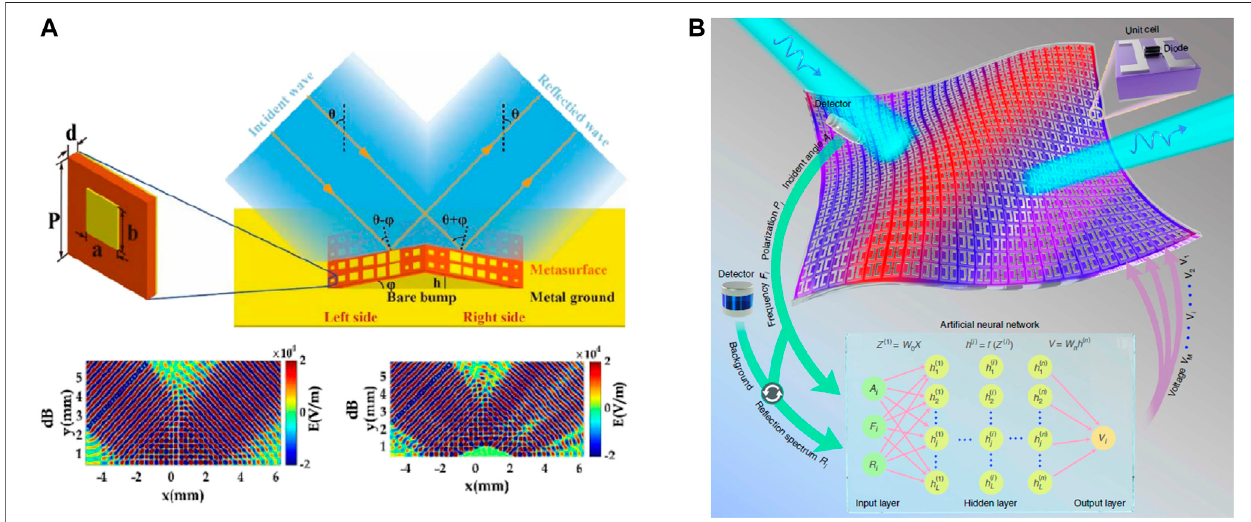
FIGURE 5 | (A) Schematic representation of the metasurface based carpet cloak [158]. (B) Deep-learning-enabled self-adaptive metasurface cloak [126]. Figure reproduced with permission from: (A) , © 2017, Optical Society of America (OSA); (B) , © 2020, Nature Publishing Group